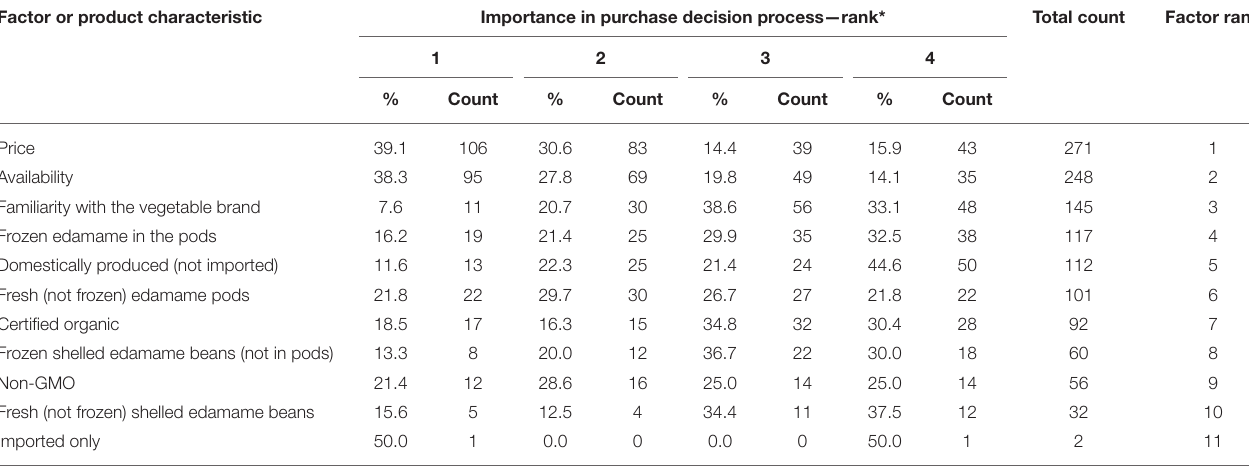
TABLE 4 | Important factors and product characteristics considered by consumers during decision process to buy edamame. Factor or product